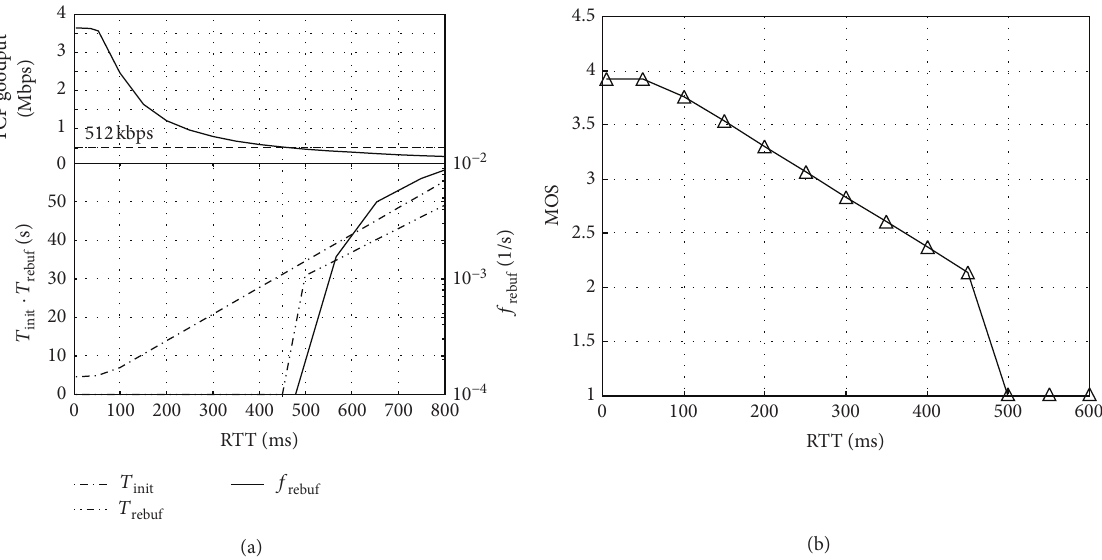
F 5: YouTube application performance metrics (a) and MOS (b) for different RTTs.